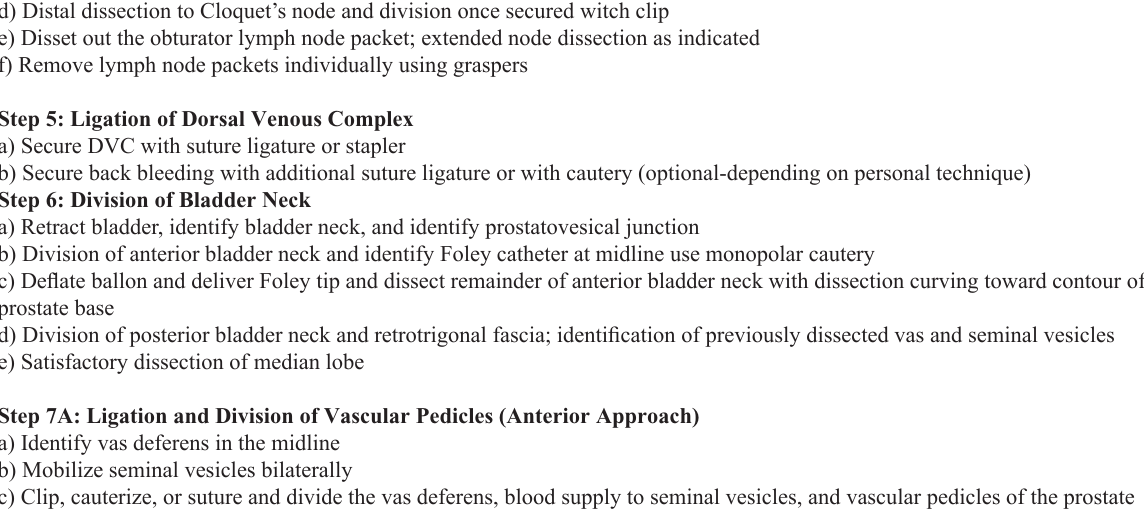
figure 2 - final inventory of steps and